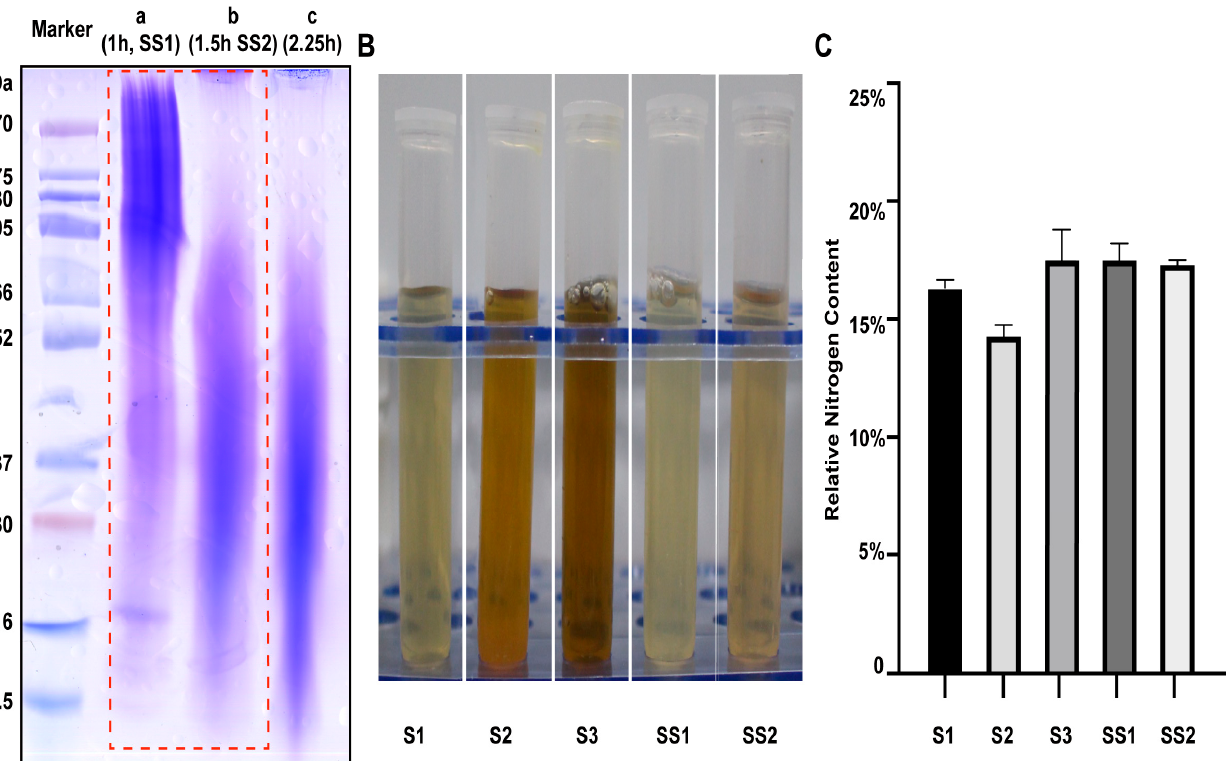
Figure 1. Properties of sericin samples. ( A ) The molecular weight of sericin obtained through different extraction times was different. ( B ) The appearance of sericin solution (13.5 mg/mL). ( C ) The relative nitrogen content of sericin samples. Table 1. The primary characteristics of the five sericin samples.